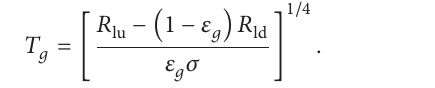
the development of ABL at last. In the experiment of 2009, of surface temperature, but it was absent in 2012. For